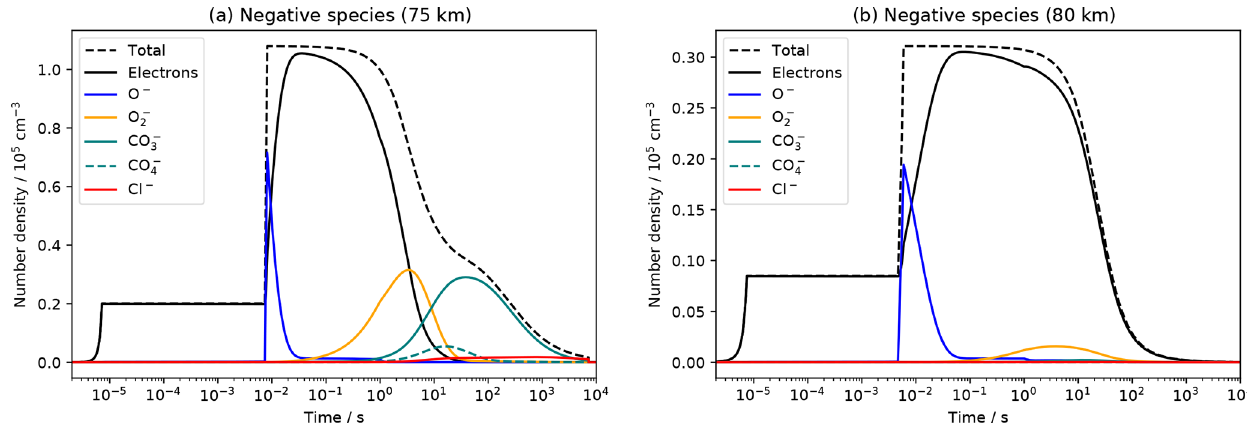
Figure 4. Modelled concentrations of the most abundant negative species under the influence of the streamer electric fields for RUN1 as a function of time at (a) 75km and (b) 80km altitude.